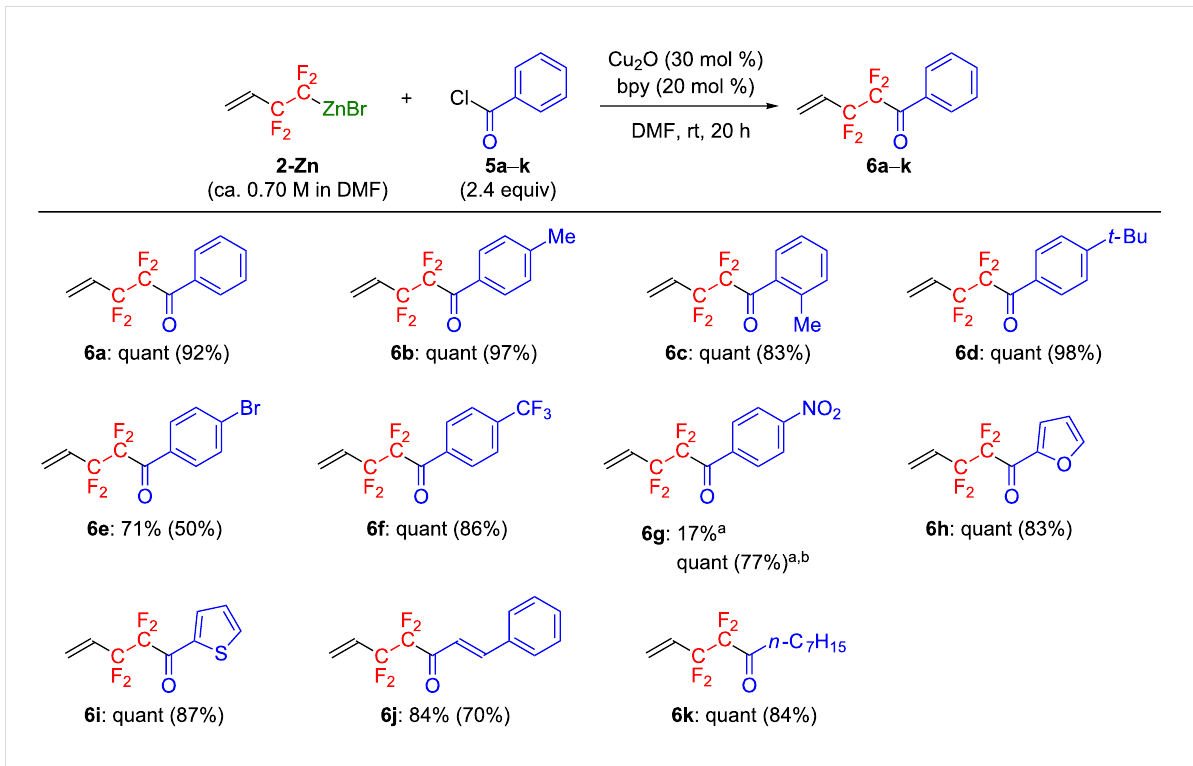
Figure 4: Copper(I)-catalyzed cross-coupling reaction of 2-Zn with various acid chlorides. NMR yields (isolated yields) are indicated. a Carried out at 100 °C. b With 4.0 equiv of 5g .